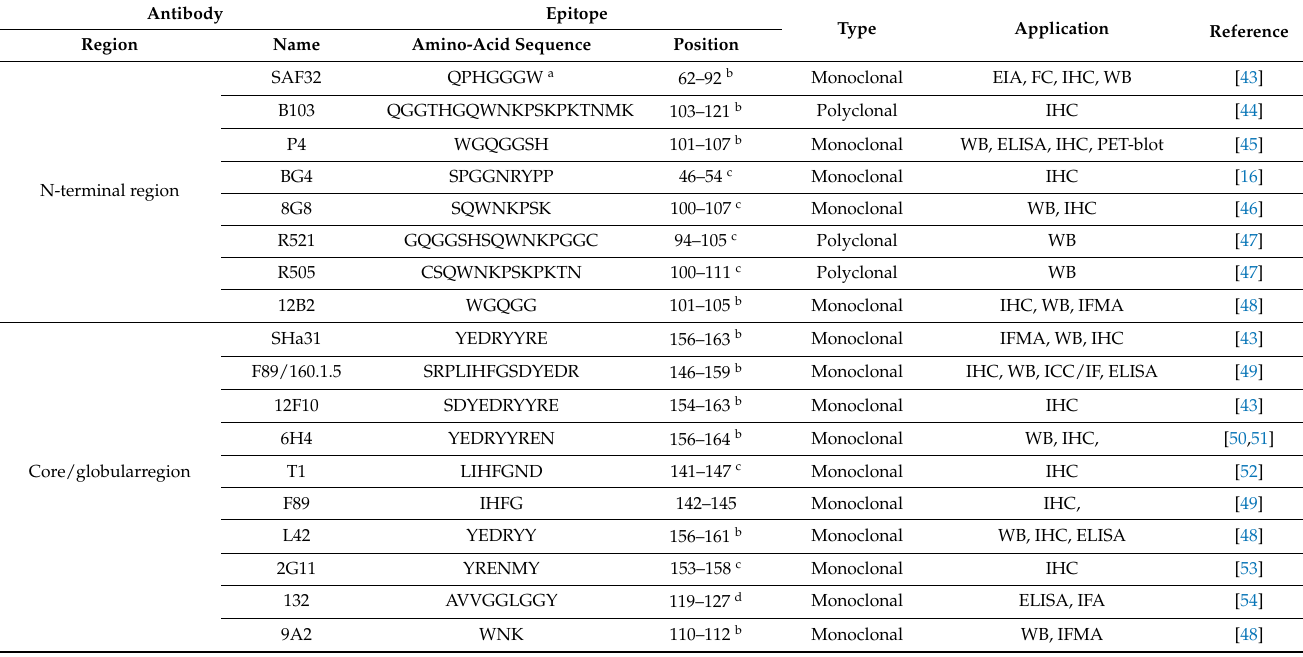
Table 2. Characteristics of the monoclonal and polyclonal antibodies used in the BSE diagnosis.